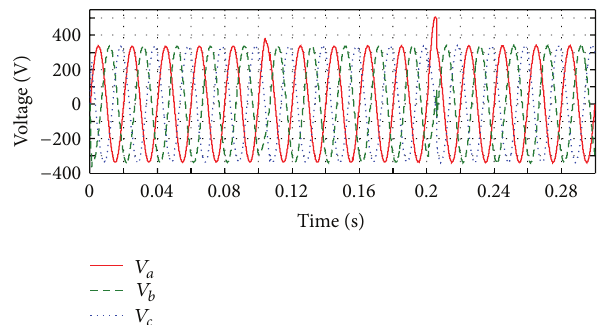
Figure 24: Output voltage waveforms (i.e., 𝑉 𝑎 , 𝑉 𝑏 , and 𝑉 𝑐 ) of the three-phase inverter with three load